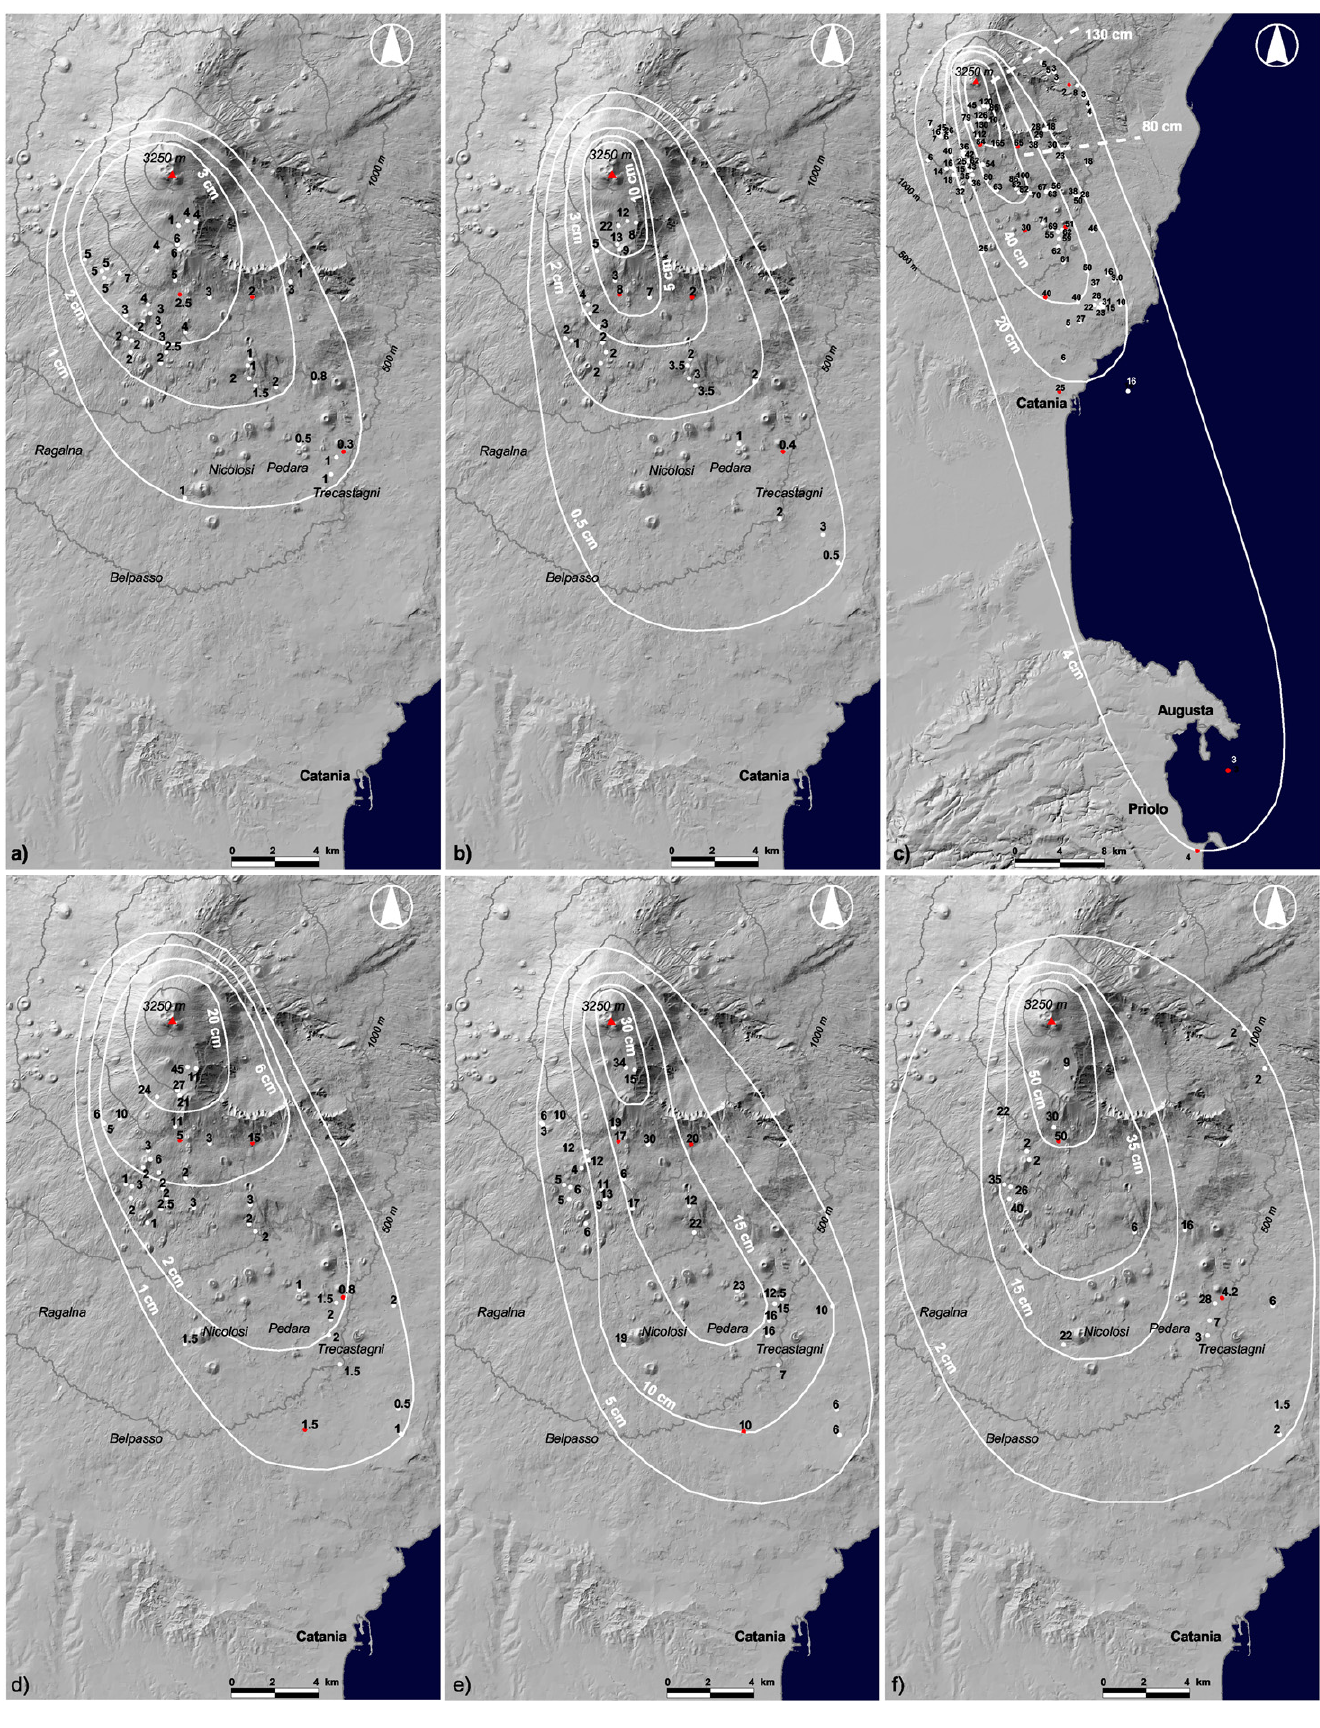
Figure 3. Measured thicknesses (cm) of the fallout deposits and isopach maps of the 122 BC Etna eruption units, according to the studied volcanic units A-F (a-f,